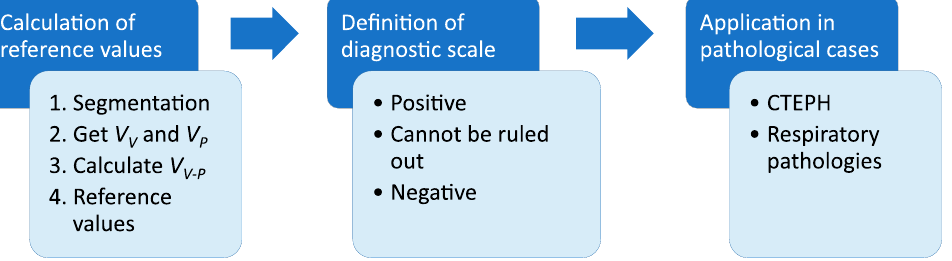
Figure 1. Methodology (CTEPH, chronic thromboembolic pulmonary hypertension).